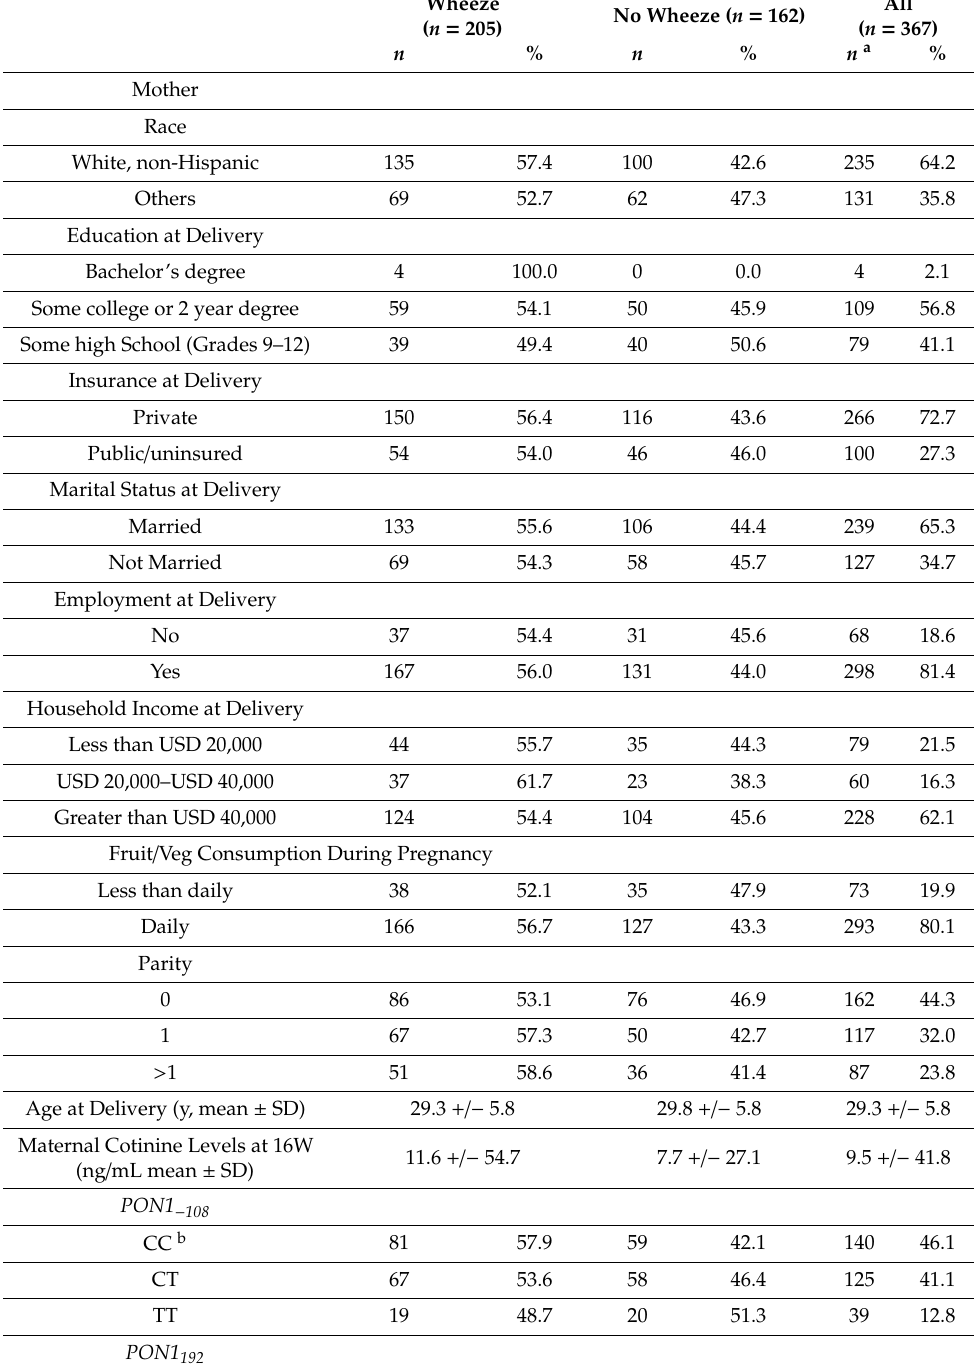
Table 1. Characteristics of participants with child wheeze data reported (N =